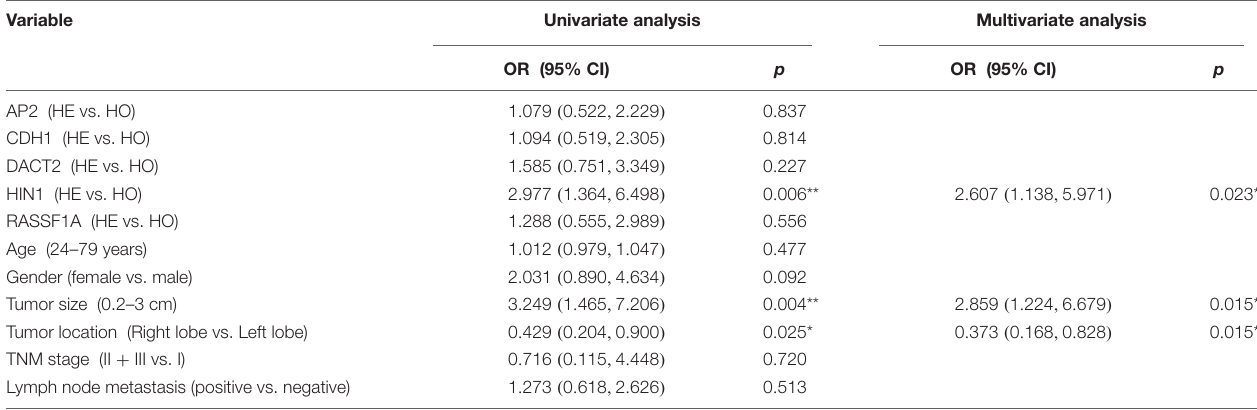
TABLE 5 | Logistic regression analysis for extrathyroidal extension.